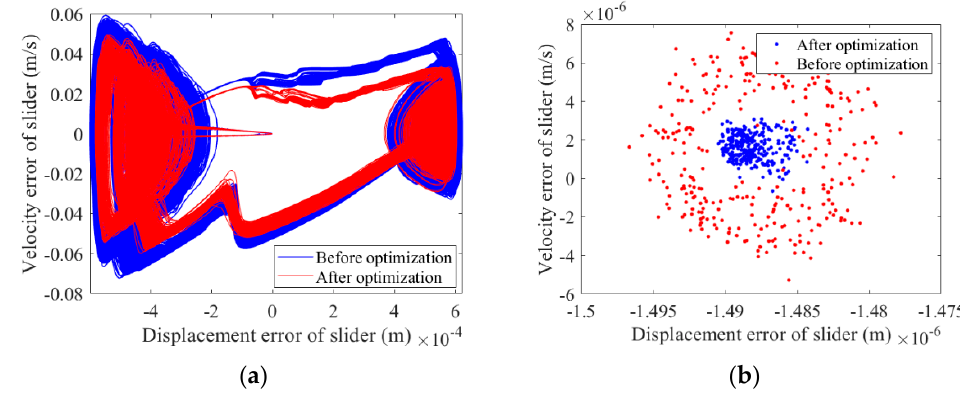
Figure 11. Nonlinear characteristic of the slider’s error. ( a ) Phase map. ( b ) Poincaré map.